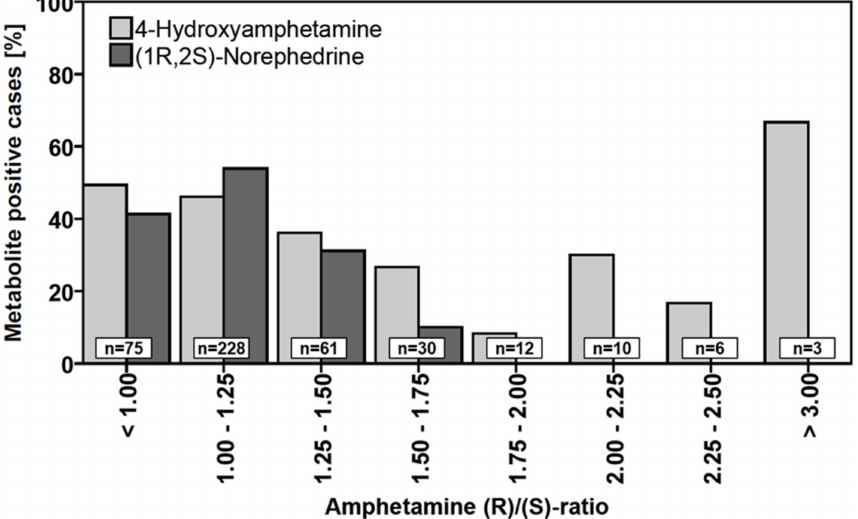
Figure 5. Histograms for relative frequency of 4-hydroxyamphetamine (any enantiomer) and (1R,2S)- norephedrine positive cases (each at least 0.5 ng/mL) within amphetamine ® /(S) concentration